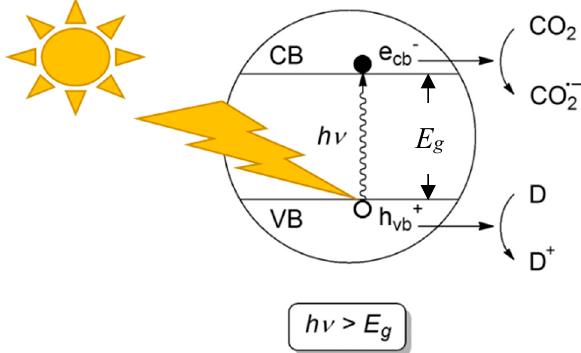
Figure 1. Generation of an electron–hole pair in a photocatalyst. Reproduced from work in [20]. Copyright 2011 Royal Society of Chemistry .